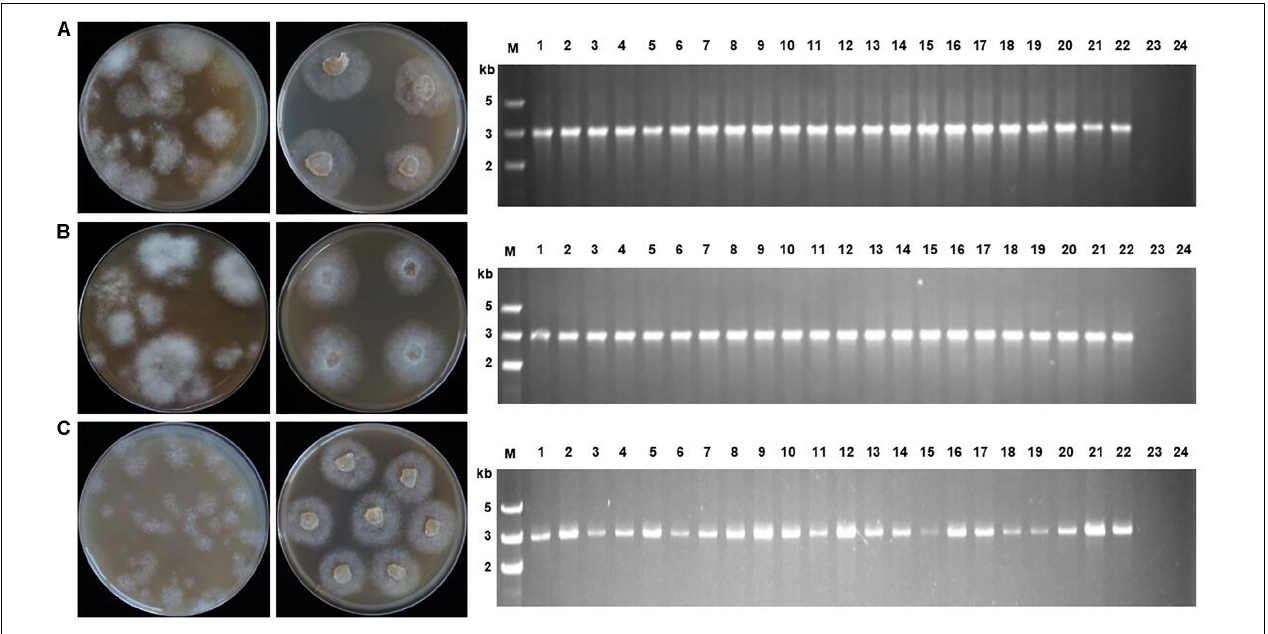
FIGURE 2 | Transformant screening on oxathiapiprolin-amended media, and PCR confirmation that transformants contained the PcMuORP1 selection marker. (A) Three plasmids co-transformation for P. capsici. (B) One plasmid transformation for P. sojae. (C) One plasmid transformation for P. litchii. Left: Colonies resulting from the second screening with V8 medium containing 0.2 µ g/ml oxathiapiprolin in the case of P. capsici , and 0.01 µ g/ml in P. sojae and P. litchii . Middle: Colonies resulting from the third screening on V8 medium containing 0.25 µ g/ml oxathiapiprolin in the case of P. capsici , and 0.01 µ g/ml in P. sojae and P. litchii . Right: PCR confirming 22 randomly selected transformants contained the PcMuORP1 selection marker. Lanes 1–22, oxathiapiprolin-resistant transformants; Lane 23, Parental isolates used as negative controls; Lane 24, Blank control.